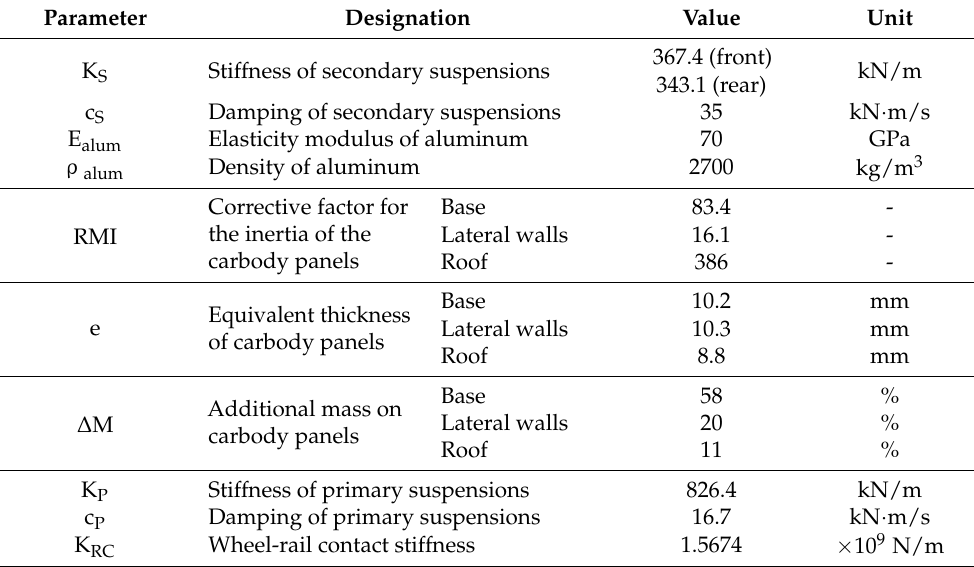
Table 2. Characterization of the main numerical model parameters of the Alfa Pendular train.